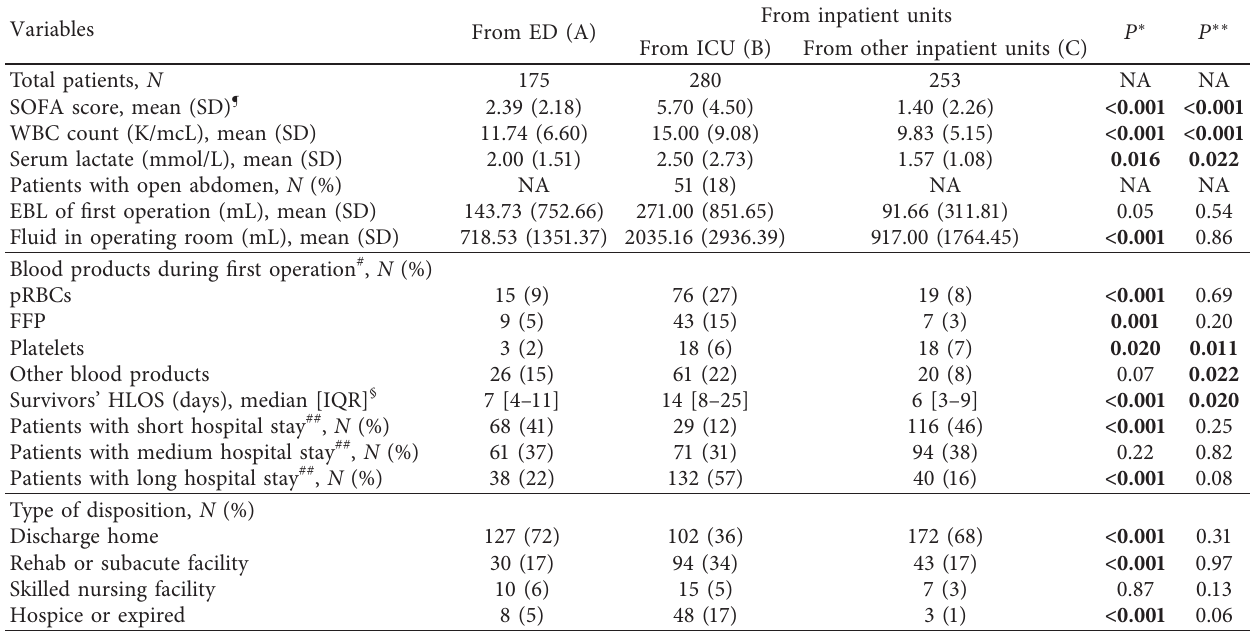
Table 3: Clinical features of patients admitted to EGS from the ED and inpatient units.